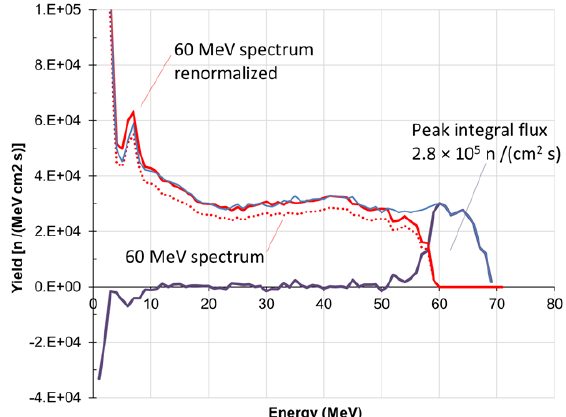
Fig. 4. The effective neutron spectrum obtained by subtraction of neutron spectra generated by 60 MeV (renormalized) and 70 MeV proton